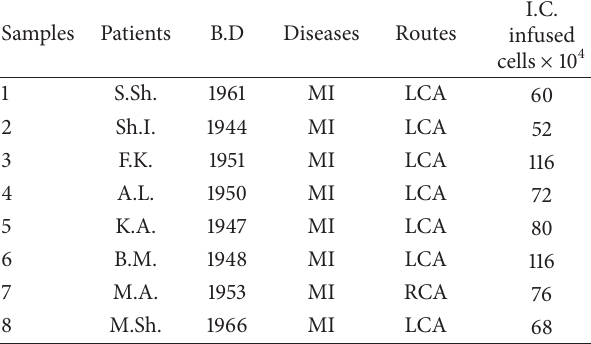
Table 2: characteristics of patients. Samples